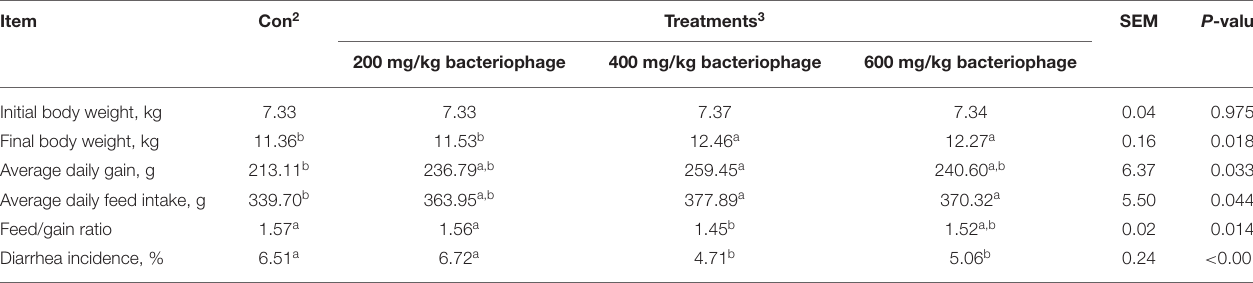
TABLE 3 | Effect of dietary bacteriophage supplementation on growth performance of weaned piglets ( n = 5) 1 .